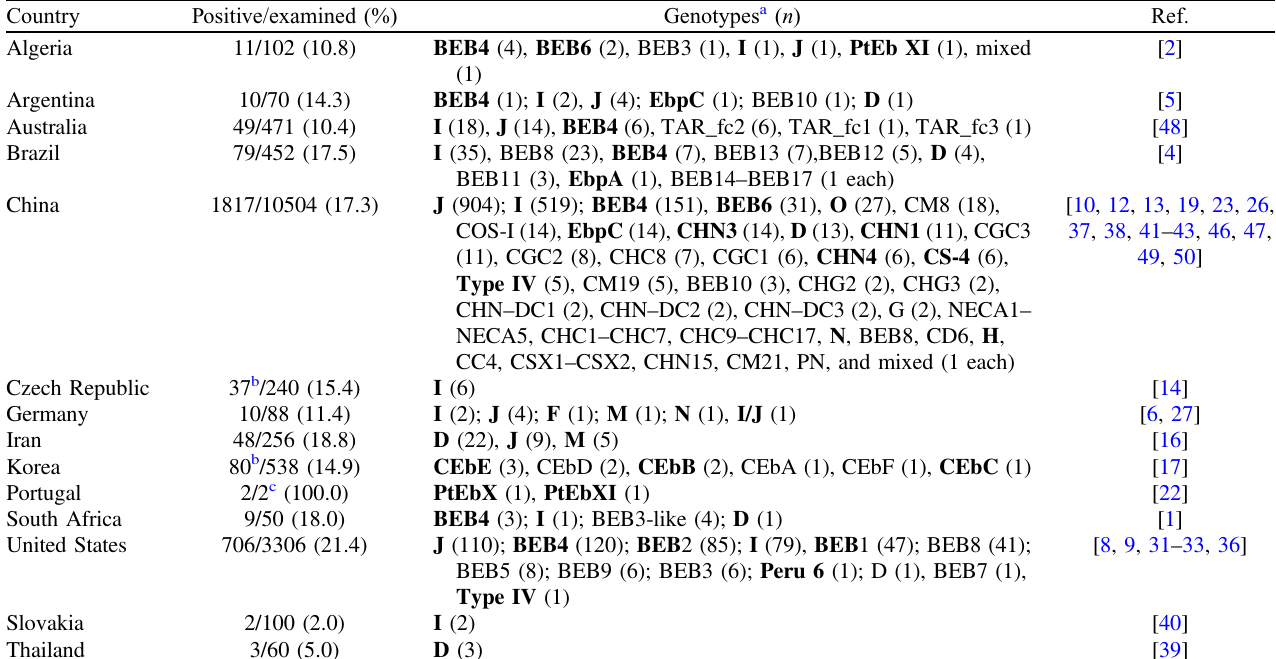
a The names of genotypes are from publications. b The number of genotypes is not consistent with the number of positives because only some E. bieneusi isolates were genotyped in the Czech Republic and Korea. c Only two isolates positive for E. bieneusi by microscopy after staining were genotyped in Portugal. The genotypes previously found in humans are shown in